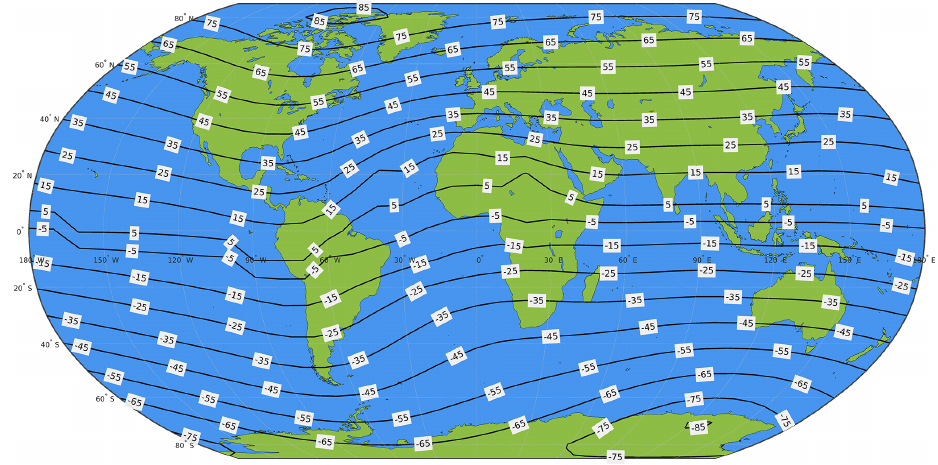
Figure 1. Geomagnetic latitude bin limits used in the